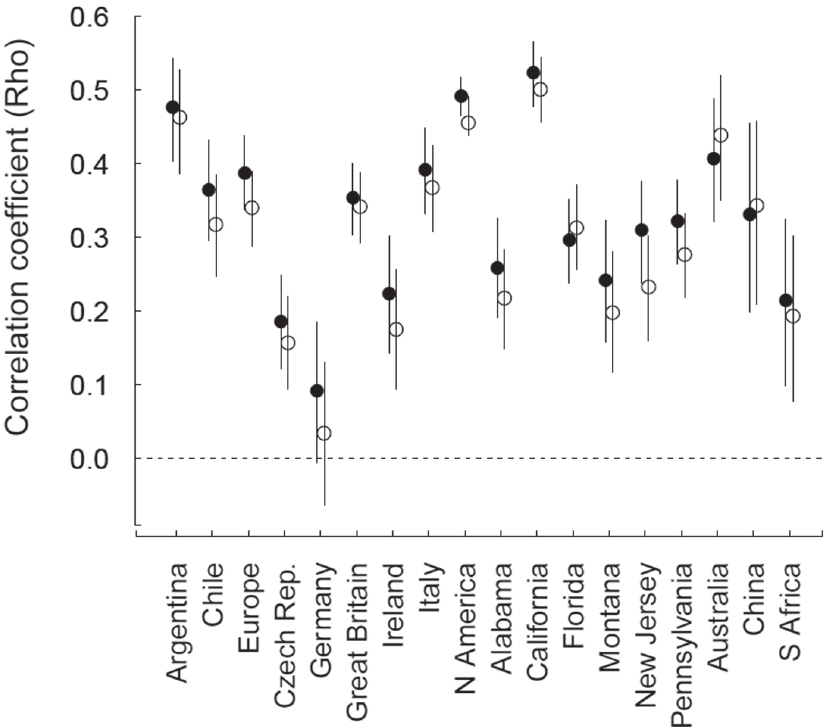
Figure 1. Spearman’s ρ correlation coefficients of the relationship between the number of GCW refer- ences (closed circles), or the number of GCW areas occupied (open circles) and the distribution (number of units occupied) of species in 18 regions. GCW measures were calculated using all non-target region references (See Fig. S2 for coefficients using ‘weed-only’ references). Error bars indicate bootstrapped, bias-corrected 95% confidence intervals; the dashed line signifies ρ